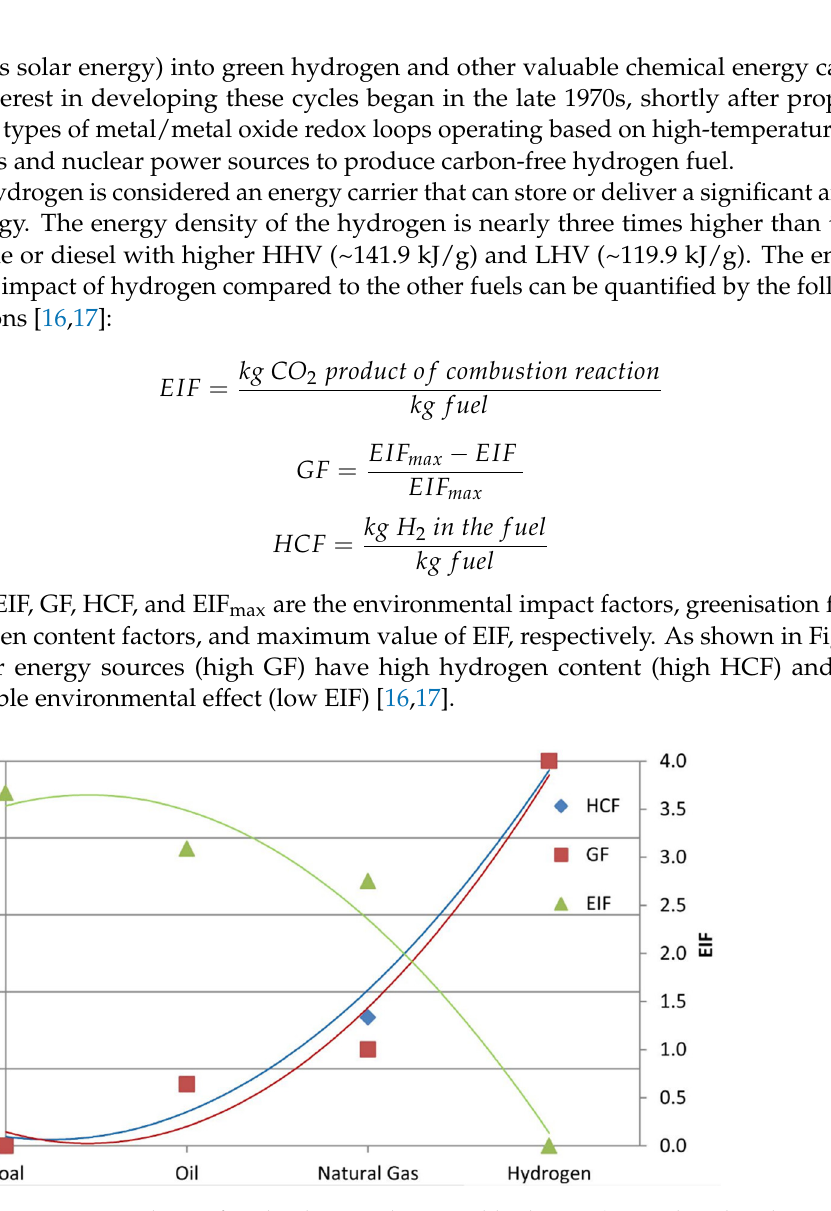
Figure 1. HCF, GF, and EIF of coal, oil, natural gas, and hydrogen (Reproduced with permission from [17], Elsevier: 2015).